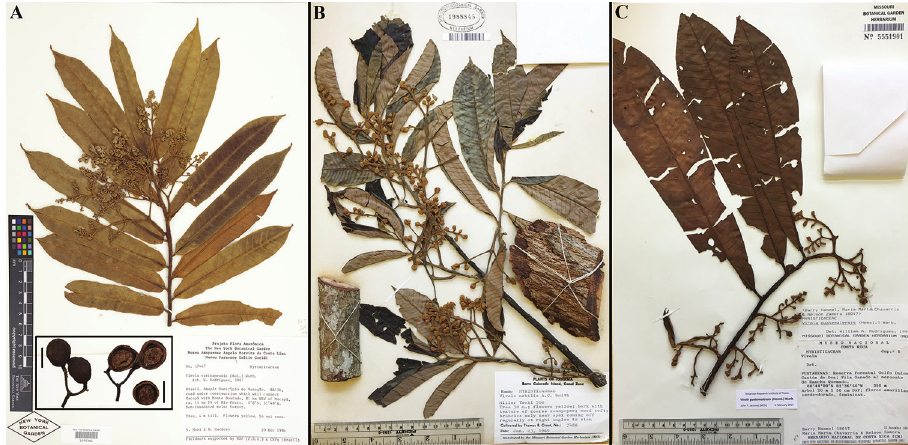
Figure 24. Comparisons of Virola surinamensis with collections of V. nobilis A V. surinamensis ( S. Mori & R. Cardoso 17467 , NY; inset showing fruits from W. E. Broadway 5264a, MO) B V. nobilis ( T. B. Croat 7488 , MO) C V. nobilis from Costa Rica (B. Hammel 18017 , MO). A , image courtesy of New York Botanical